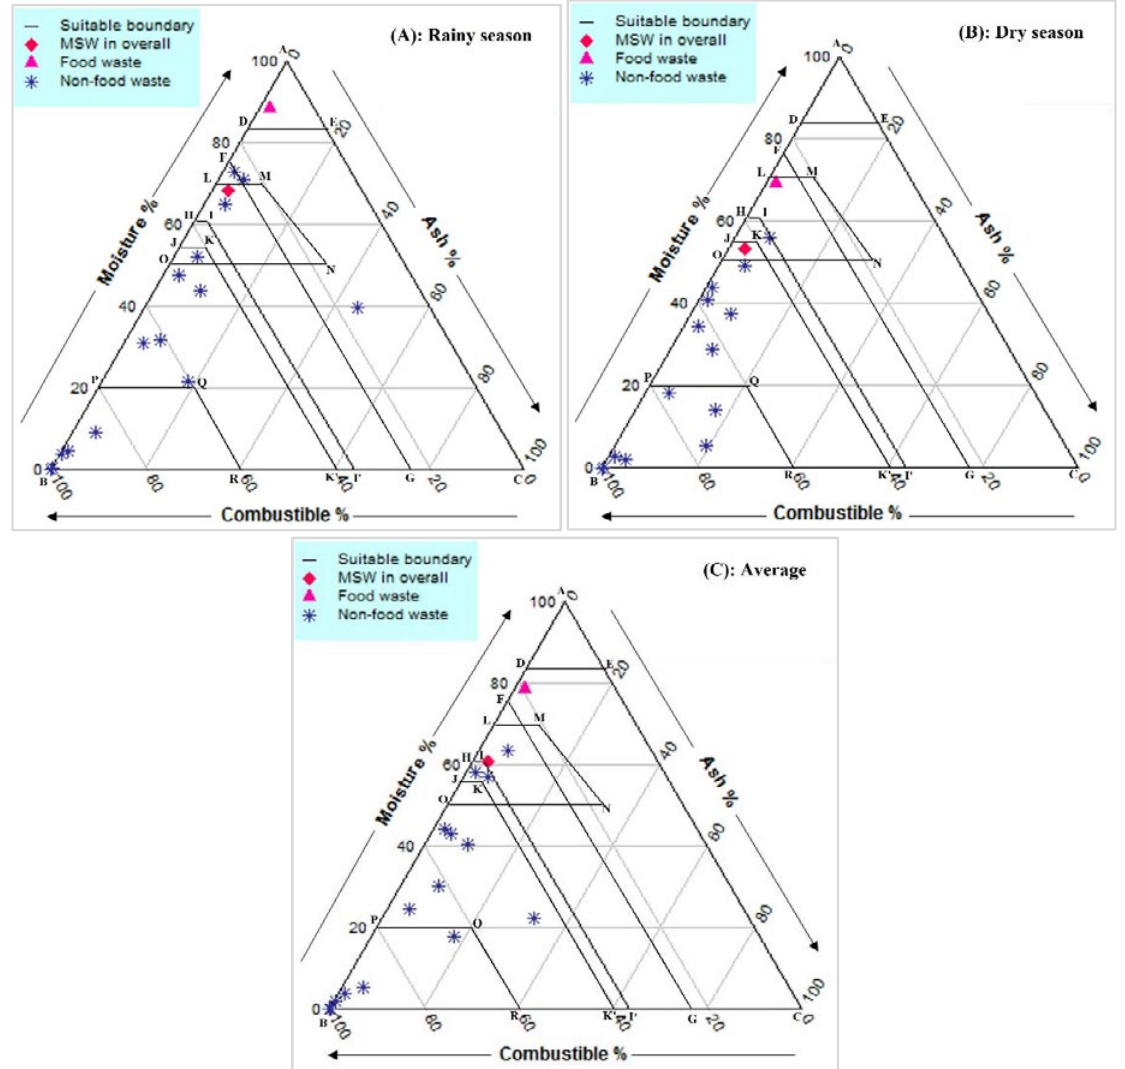
Fig. 4: Suitability in (A): Rainy season, (B): Dry season and (C): Average with trapezoid for direct landfilling (BDEC), composting (OLMN), RDF generation (BPQR), gasification with melting (BJKK’), incineration without energy recovery (BFG) and incineration with energy recovery (BHII’)